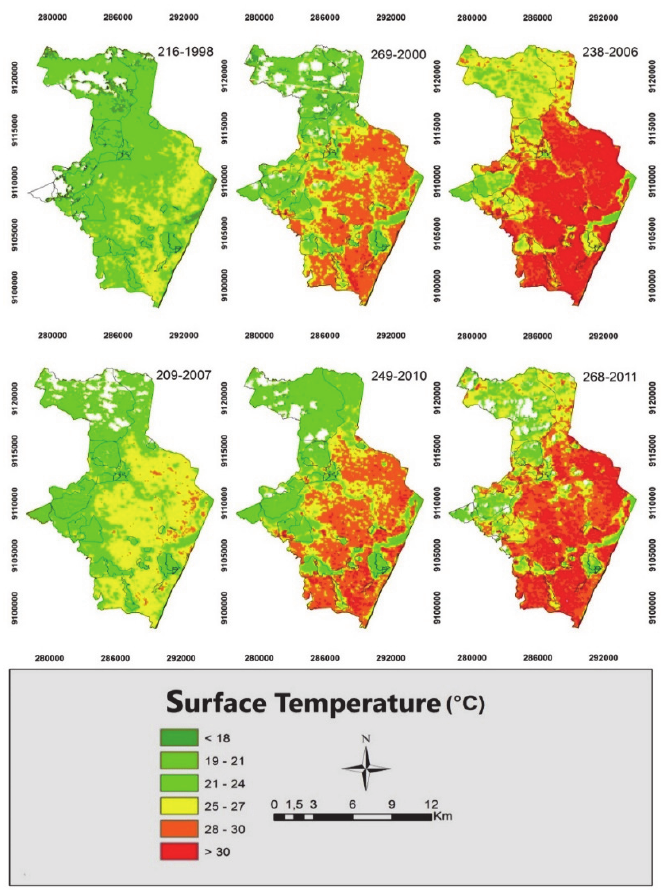
Fig. 2. Evolution of the heat islands of the metropolitan reef region by analyzing the spatial distribution of surface temperatures between 1998 and 2011.